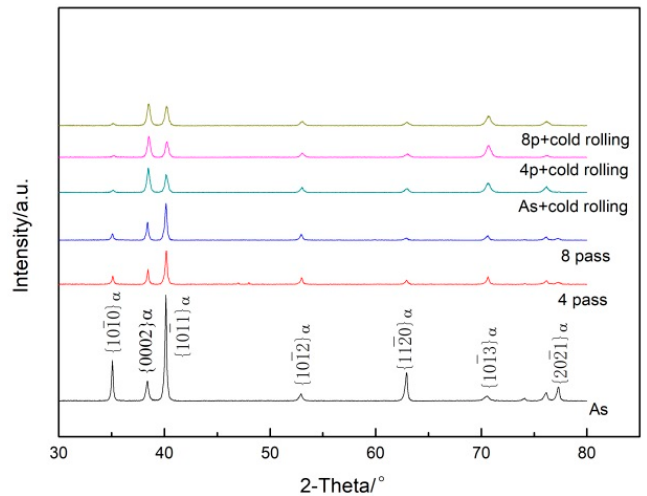
Figure 2. XRD (X-ray diffractometer) patterns of the CP-Ti (Commercially pure Titanium) at different processing stages.